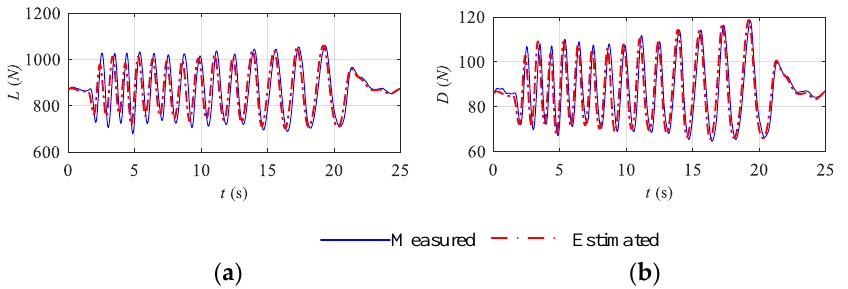
Figure 12. Comparison of the simulation results of the aerodynamic model obtained by identification and wind tunnel test data: ( a ) lift; ( b ) drag.